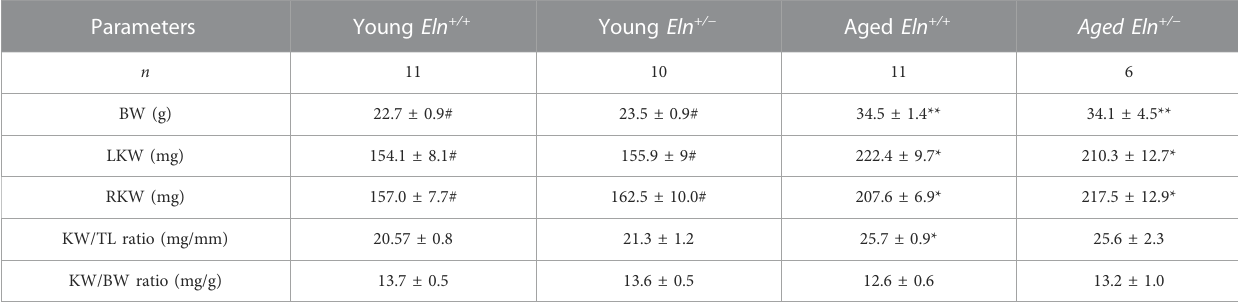
TABLE 1 Body weight and kidney weight of young and aged Eln +/+ and Eln +/ − mice.